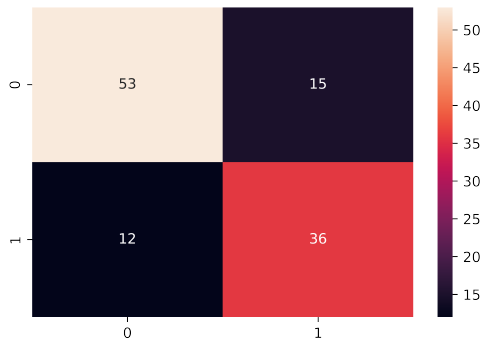
Figure 5. The confusion matrix. On the upper left side, true negatives (TP), on the upper right side, the false positives (FP), on the lower left side false negatives (FN) and on the lower right side, the true positives (TP): 1 is the number of observations per subject with depression and 0 is the number of observations per healthy subject.